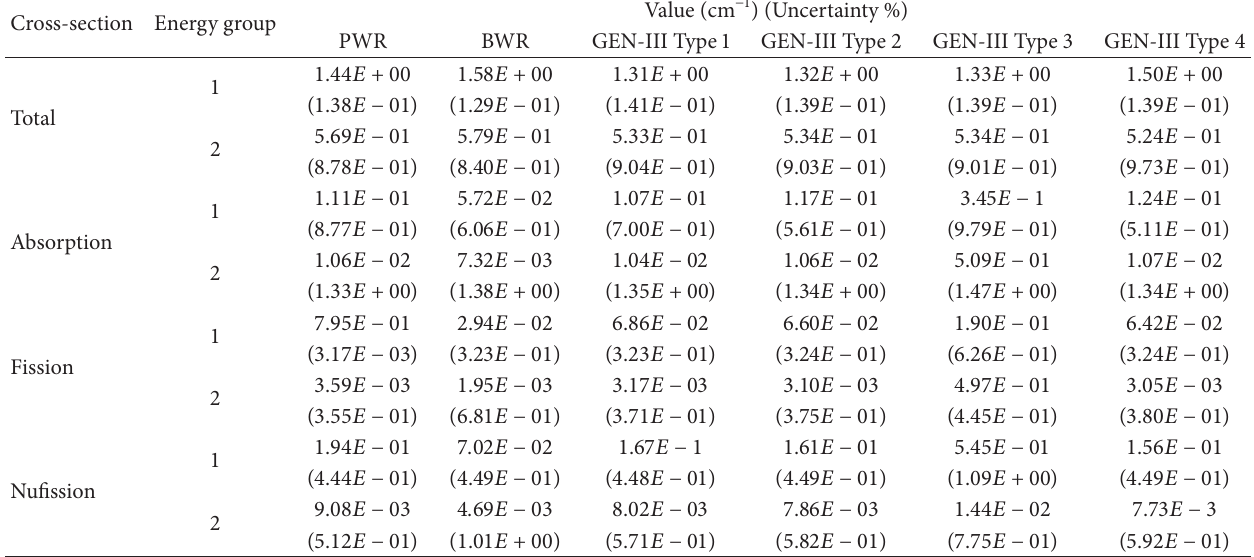
Table 5: Exercise I-2 results: macroscopic cross-sections.